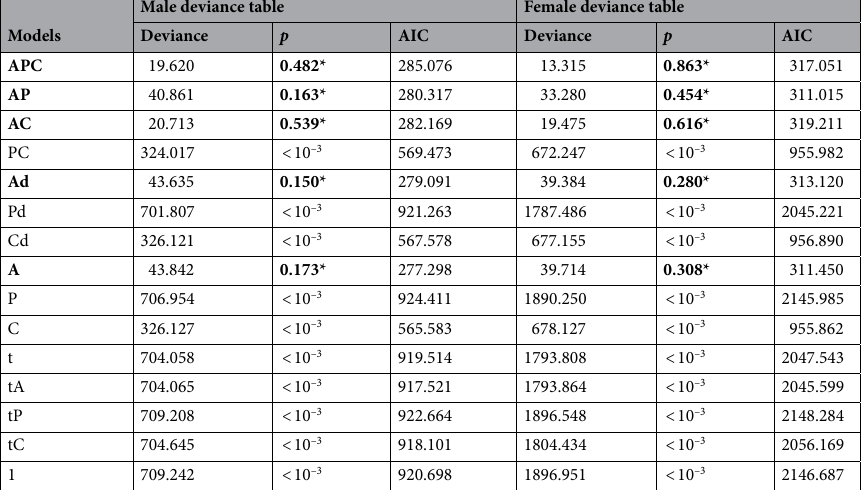
Table 3. Deviance table of sex-specific age-period-cohort model. * p ≥ 0.05. AIC, Akaike Information Criterion. All models are defined in the footnote of Fig. 5. Analysis of the deviance of the sex-specific age- period-cohort models. The p -value of each nested model is analyzed. For p ≥ 0.05, the corresponding model cannot be rejected; the parameters contained in this model may have affected the evolution of MS incidence over the study period. Sub-models at p < 0.05 can be rejected: there is no effect of the parameters contained in this sub-model that is